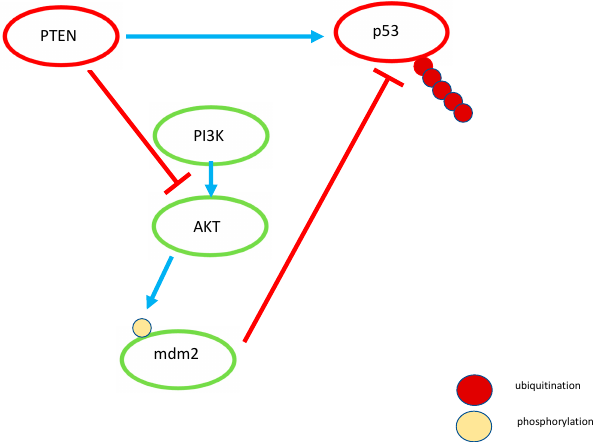
Figure 2. Schematic relationships between PTEN, MDM2, and p53. In addition to being the main negative regulator of the PI3K/AKT pathway, PTEN also regulates stability and transcriptional activity of p53 (tumor suppressor). Moreover, PTEN itself is a transcriptional target of p53. Another transcriptional target of p53 is a E3-ubiquitin ligase, MDM2. Importantly, MDM2 mediates the proteasomal degradation of p53. In addition, MDM2 also mediates autoubiquitination thus rendering itself an unstable protein. AKT can phosphorylate MDM2 thereby stabilizing the latter and promoting the degradation of the tumor suppressor p53. Expression of the constitutively active form of AKT augments the nuclear entry of MDM2. Light blue arrows denote activating transduction events between the members of a particular pathway (shown as circles of different colors). Red crossbars denote the inhibitory events.